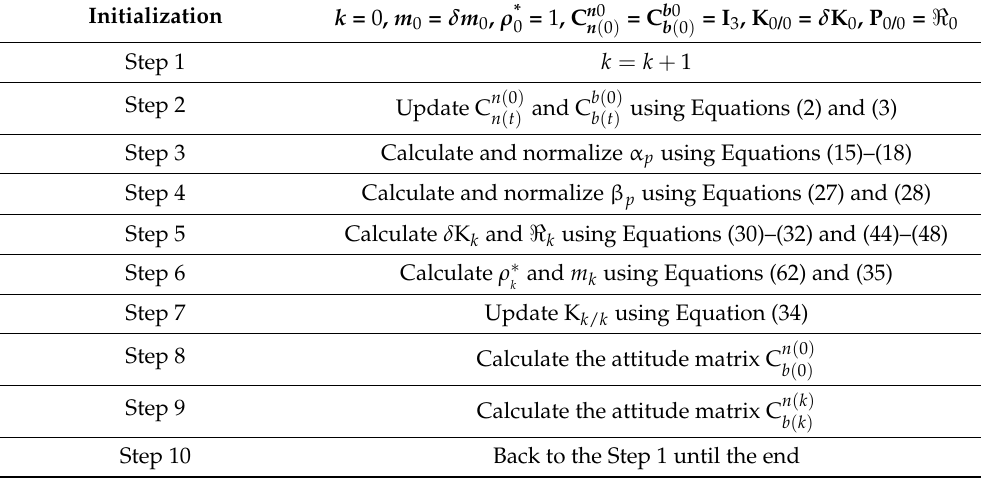
Table 1. In-motion coarse alignment based on the OP-PL algorithm.